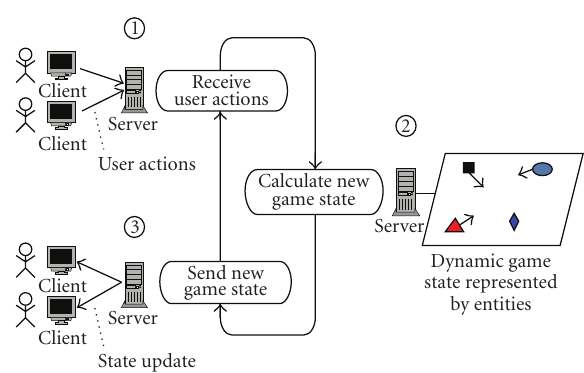
Figure 1: One iteration of the server real-time